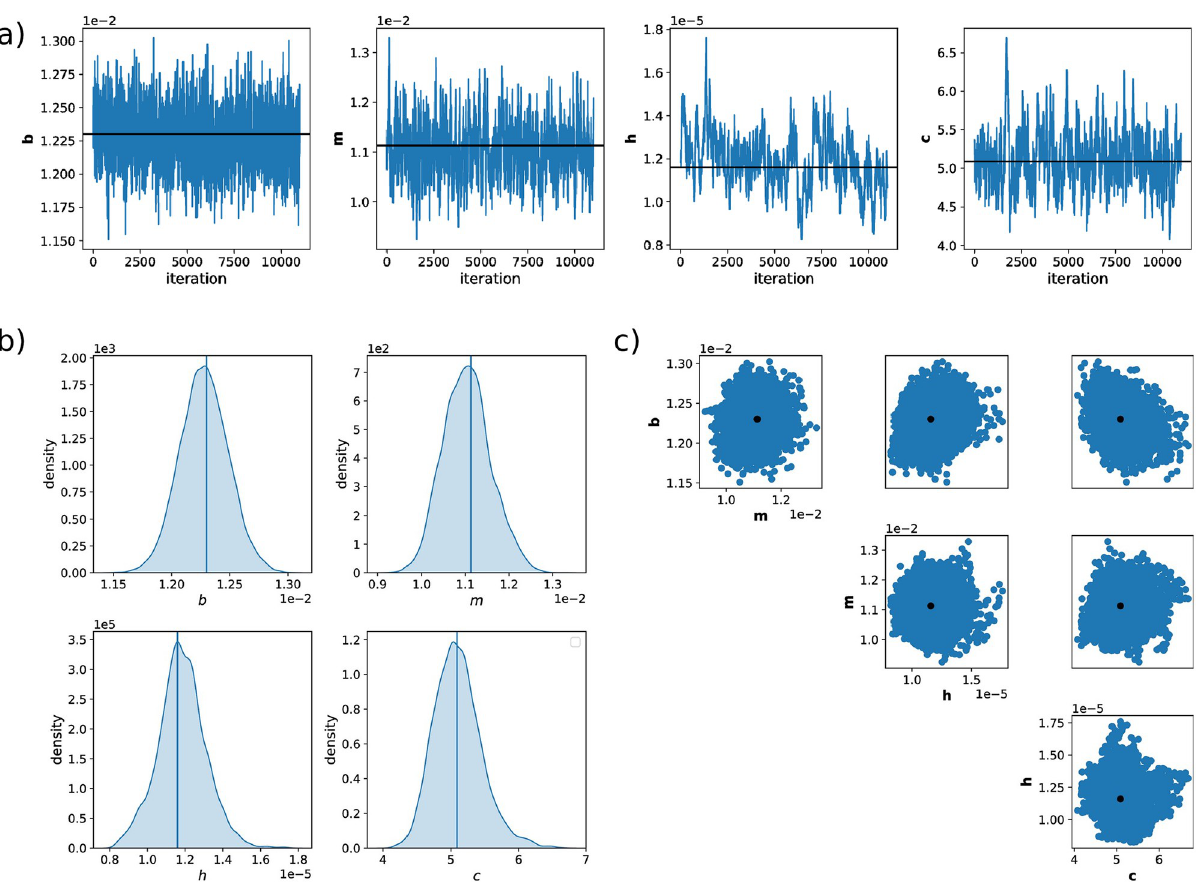
Fig 8. Parameter inference using Algorithm 1 on experimental data. a) MCMC chains, after a burn in period, for parameters b , m , h and c . Black lines show values and the position in the chain of the MAP estimator. b) One-dimensional marginals of posterior distributions. c) Two-dimensional posterior marginals of the MCMC parameter search of 14 000 iterations in total and the burn-in period of 3 000 iterations. Black dots show the values of the parameters of the MAP estimator. Data used for inference: 30 cells in total, 5 cells per light group, as in G0, shown in Fig 7.